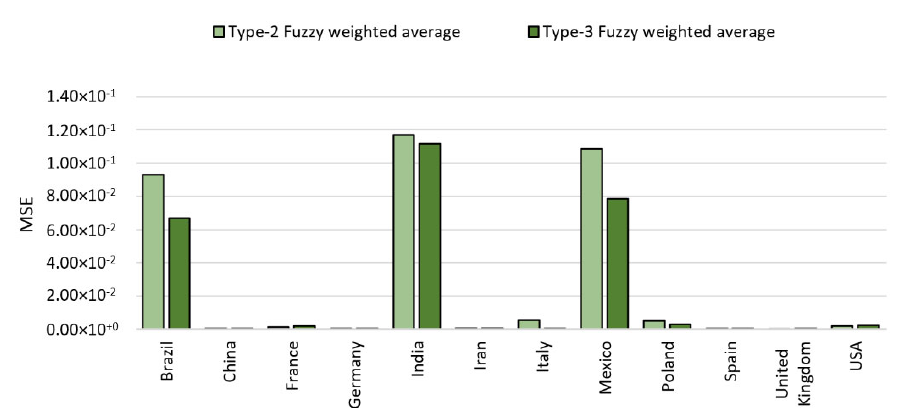
Figure 28. Second data period (testing prediction).